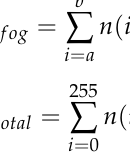
Figure 4. Foggy image at sea and its grayscale histogram. A comparative analysis of the distribution characteristics of the grayscale histogram of the sea surface image with fog and the sea surface image without fog shows that the percentage r of pixels with pixel brightness between a and b in the grayscale image with fog is higher than that of the grayscale image without fog. The image at sea is calcu- lated based on the above properties.